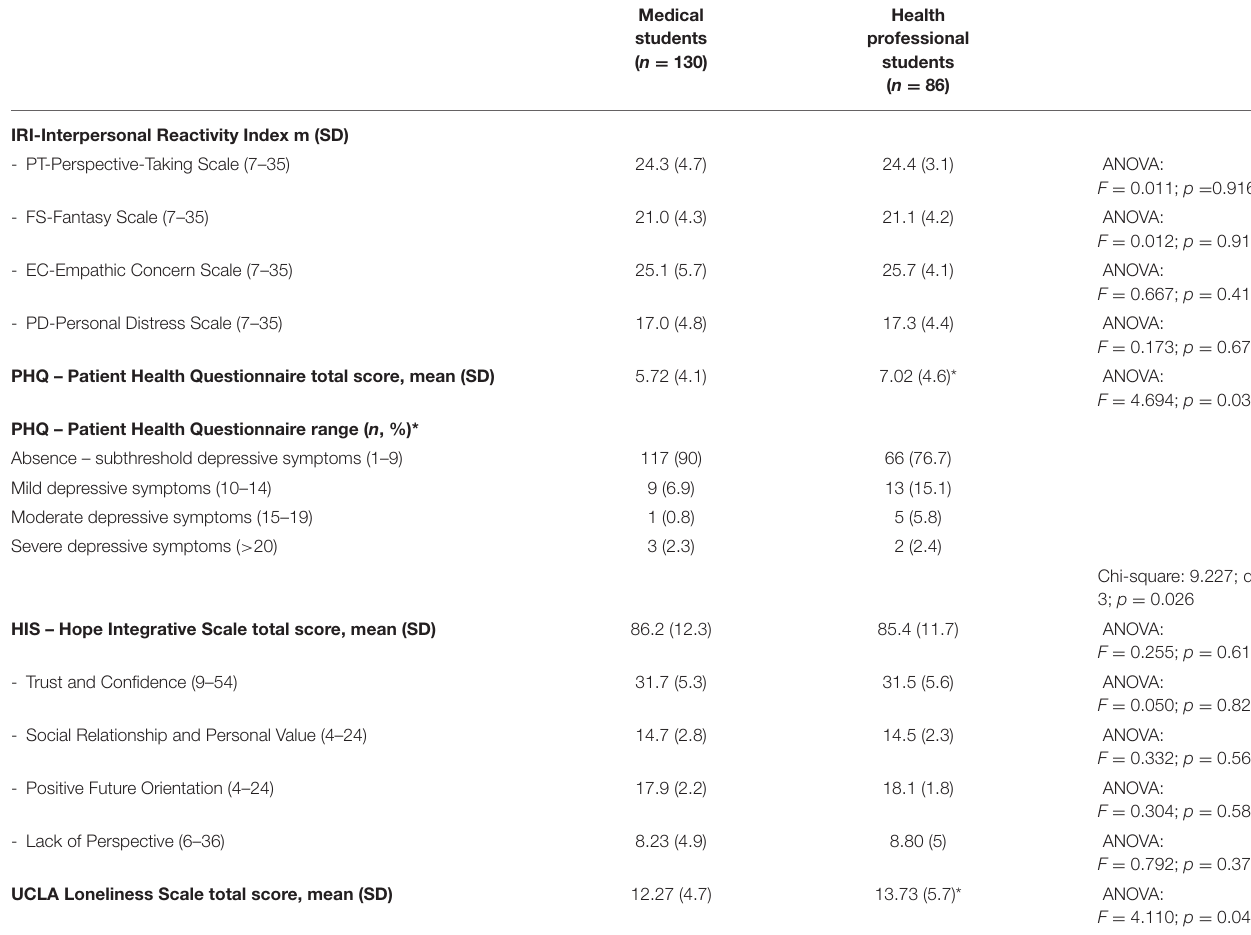
TABLE 3 | Means and standard deviations of clinical and psychological measures of total sample ( n =